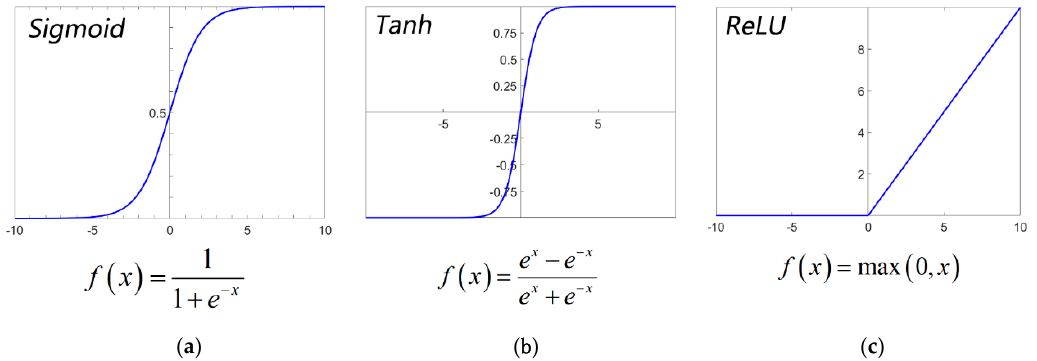
Figure 5. Diagram for different activation functions and its characteristics: ( a ) Sigmoid; ( b ) Tanh; ( c ) ReLU.